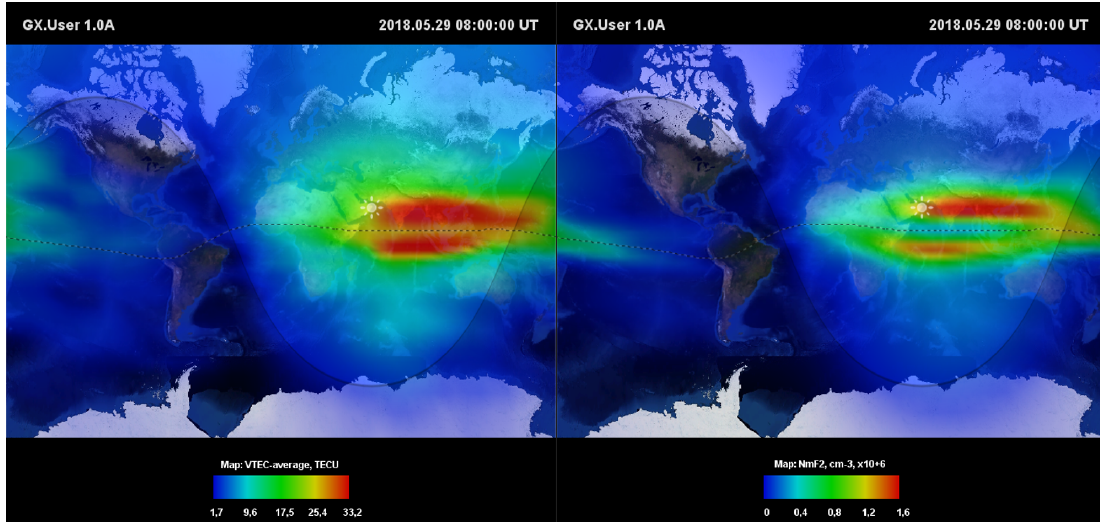
Figure 6. Comparison of climate VTEC and climate NmF2 as seen in GAMBIT Explorer. Climate VTEC derived from IGS network reflects expected quiet-time reference VTEC. Climate NmF2 from IRI model shows typical quiet-time plasma